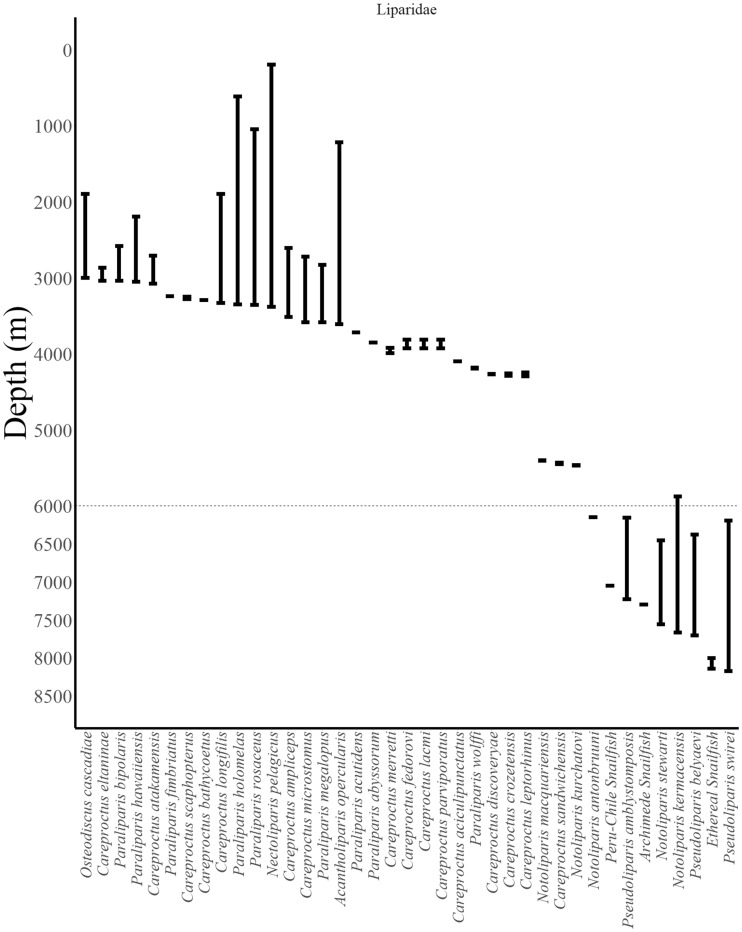
Reported depth distributions of deep-dwelling fishes (collections >3000 m) by family (Liparidae). Abyssal–hadal boundary at 6000 m shown as dotted line. Data from FishBase (Froese and Pauly 2014) checked in the primary literature (Nielsen 1977; Andriashev and Stein 1998; Nielsen et al. 1999; Chernova et al. 2004; Chernova 2006; Duhamel and King 2007; Moller and King 2007; Jamieson et al. 2009; Linley et al. 2016, 2017; Gerringer et al. 2017b). Excludes the liparids Psednos griseus and P. melanocephalus, which are each known only from one individual, collected somewhere between 0 and 4000 m depth (Chernova and Stein 2002).